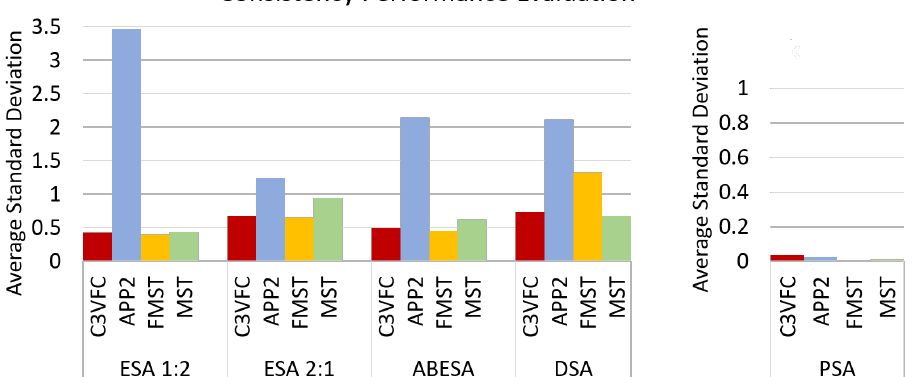
Figure 9. Consistency measure for the reconstruction results over time. We compare the standard deviations over time of the five performance measures (ESA 1:2, ESA 2:1, ABESA, DSA, and PSA) for each of the reconstruction algorithms (C3VFC, APP2, FMST, and MST). A lower average standard deviation constitutes a more consistent change over time. The scale for the PSA graph is from 0 to 1 because the PSA is a